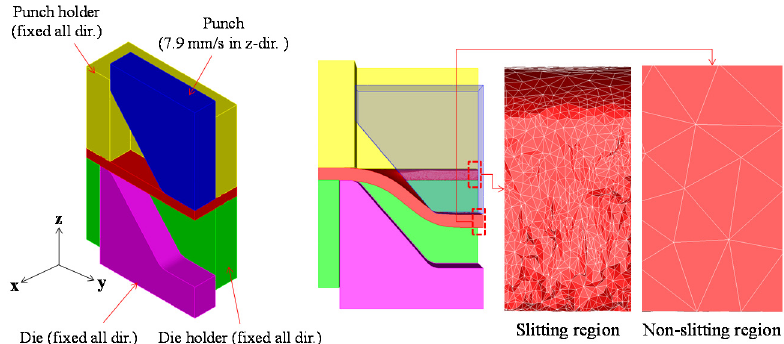
Figure 6. Quarter model and boundary condition for FE analysis.